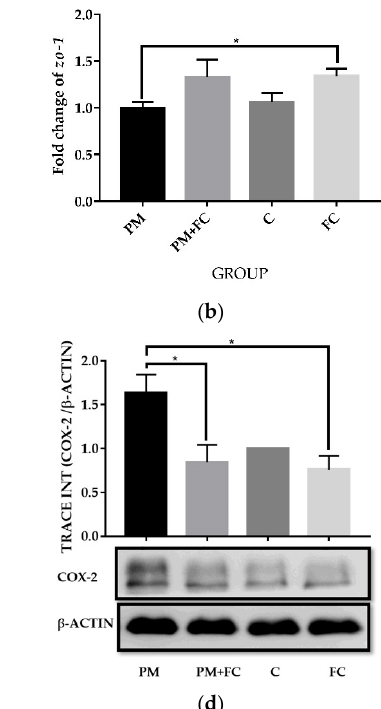
( c ) Figure 9. α diversity of gut microbiota at T1 ( a ), T2 ( b ), and T3 ( c ). NS p ≥ 0.05, * p < 0.05, ** p < 0.01.